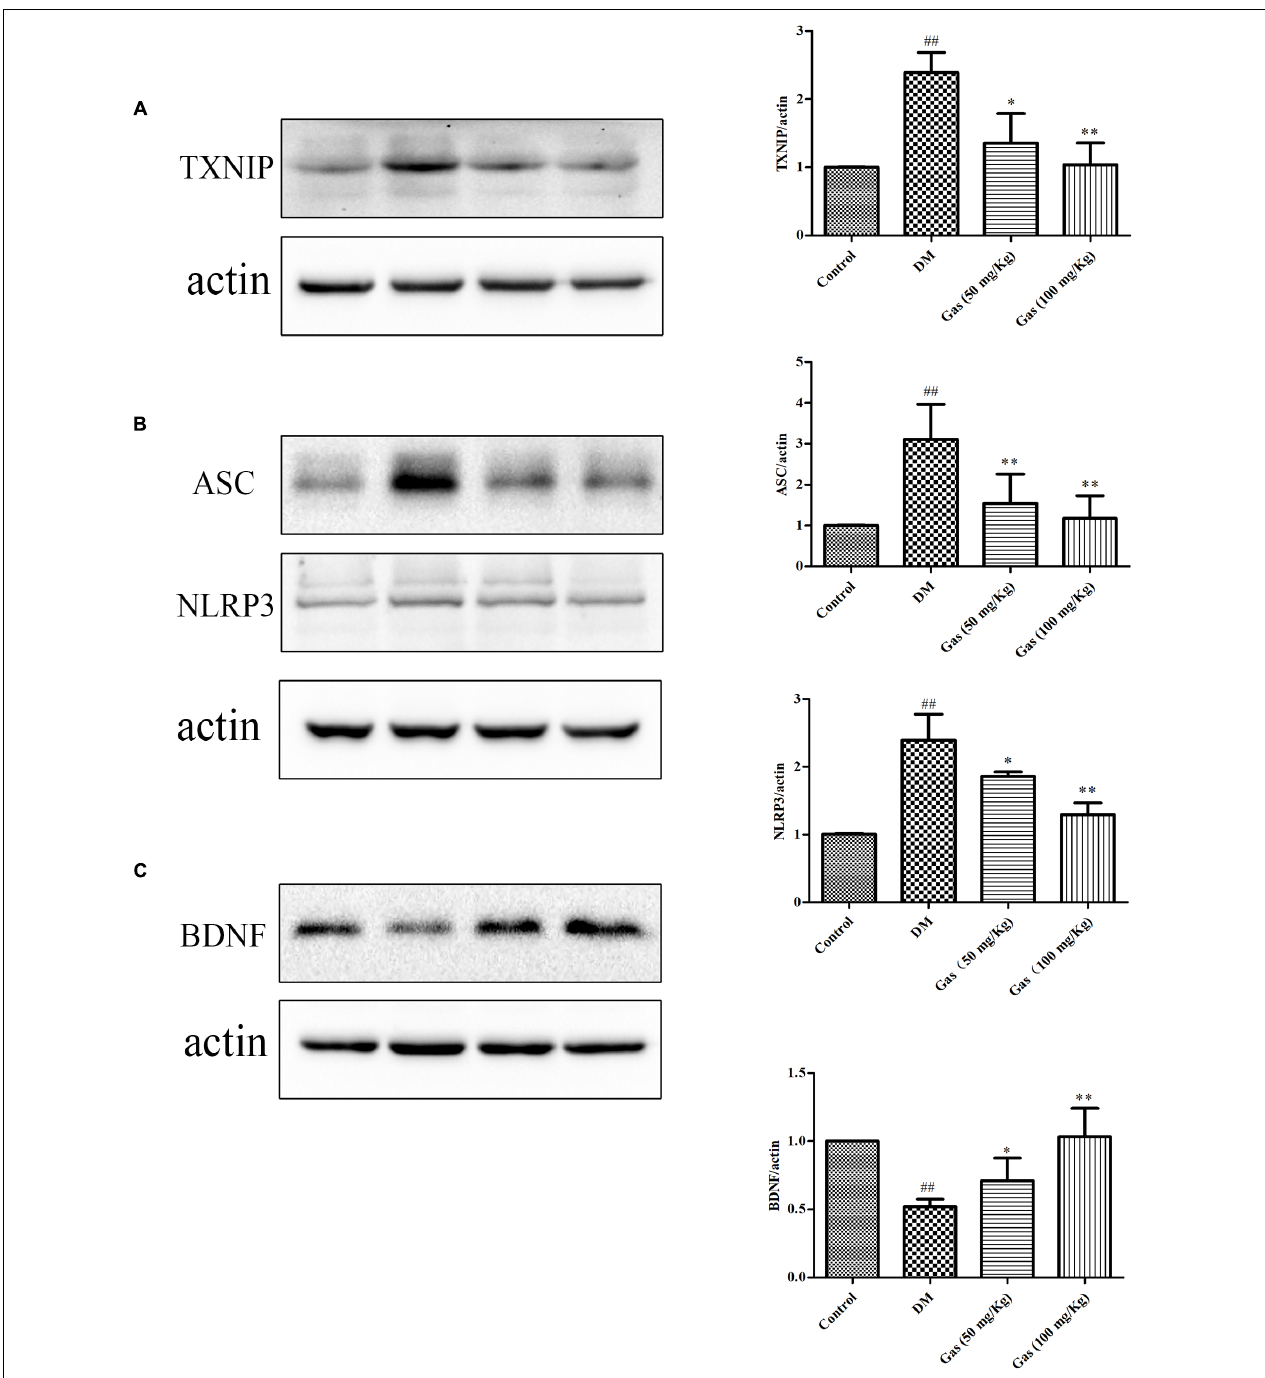
FIGURE 9 | Gas inhibits TXNIP, NLRP3 inflammasome activation and increases expression of BDNF in the hippocampus of DM rats. (A) Representative protein bands and Western blot analysis of TXNIP in the hippocampus of each group. (B) Representative protein bands and Western blot analysis of NLRP3, ASC in the hippocampus of each group. (C) Representative protein bands and Western blot analysis of BDNF in the hippocampus of each group. Values are represented as means ± SD for three rats in each group. ## P < 0.01, compared with the control group. ∗ P < 0.05, ∗∗ P < 0.01, compared with the DM group.